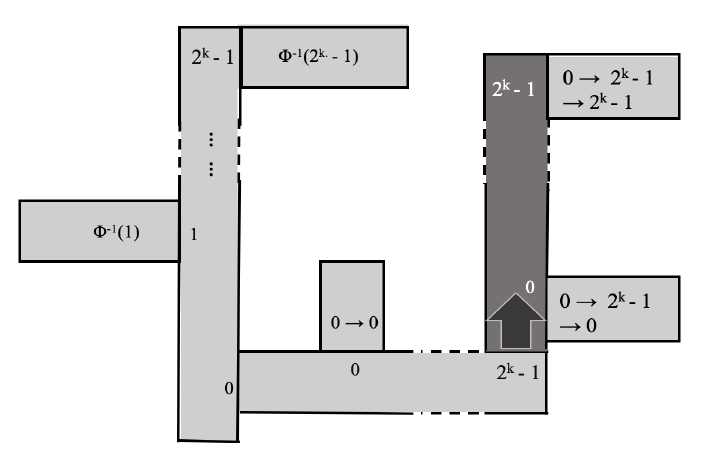
Figure 5. Three-dimensional ( L = 3) visual of the corner-turning process, assuming the turns 0,2 k −